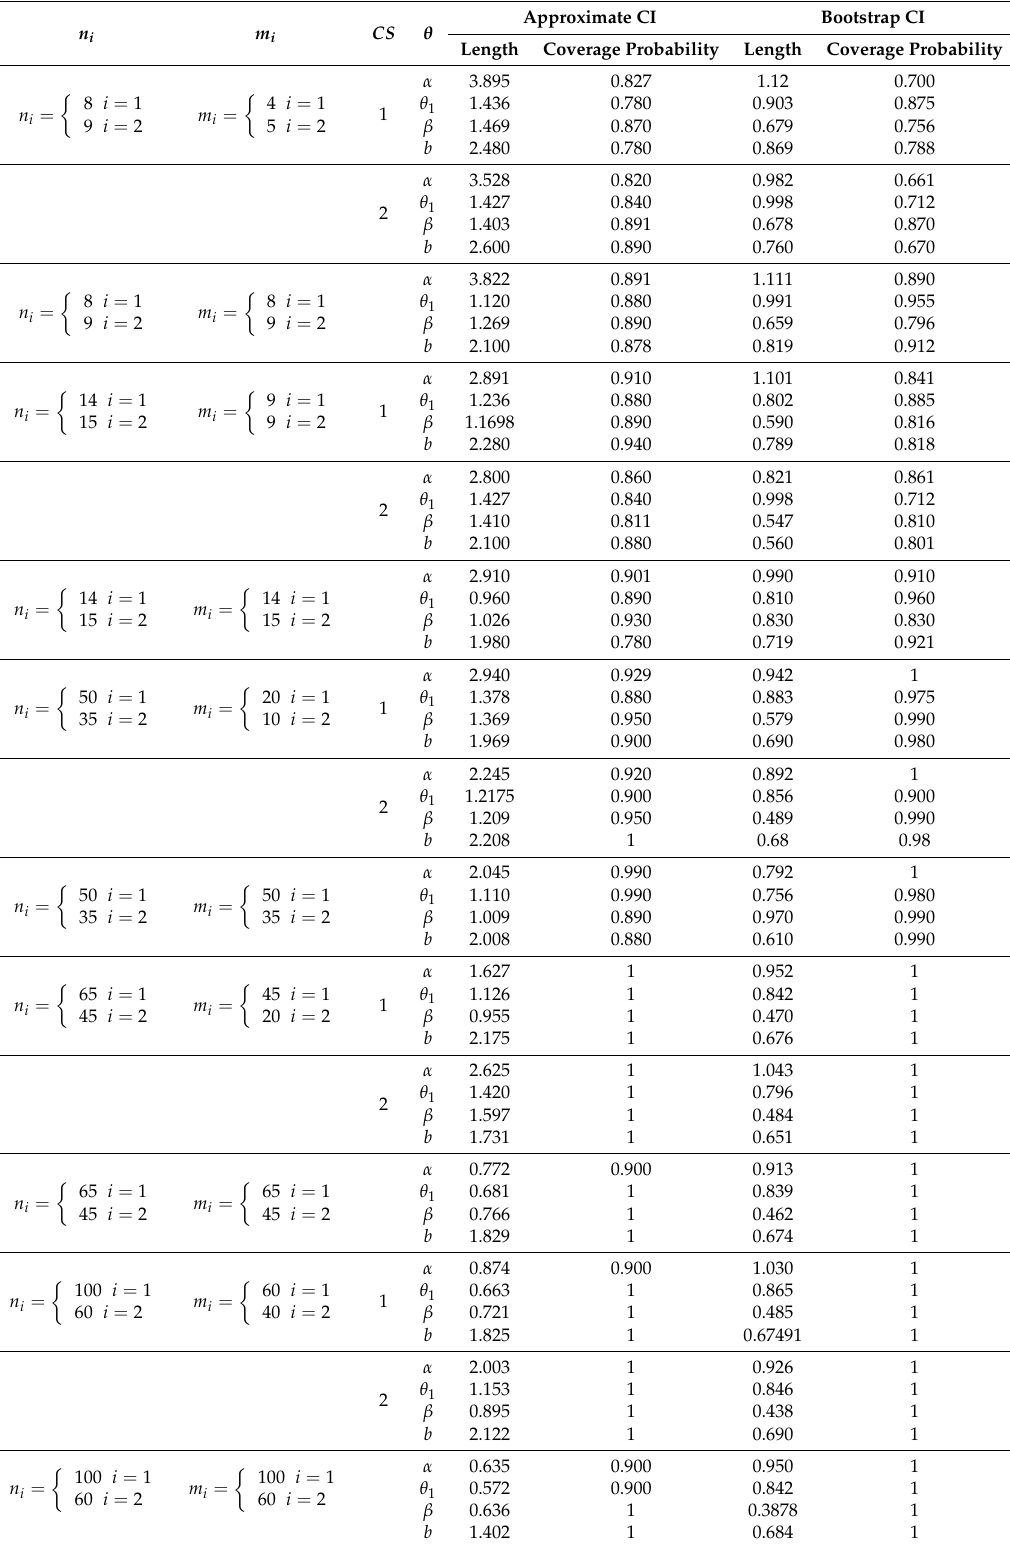
Table 6. Lengths and coverage probabilities of 95% approximate and bootstrap CIs of α , θ 1 , γ and b with true values ( γ = 1.4, α = 0.5, θ 1 = 0.7 and b = 1.2), k = 2, ν 1 = 10, and ν 2 = 16. Approximate CI Bootstrap CI n i m i CS θ Length Coverage Probability Length Coverage